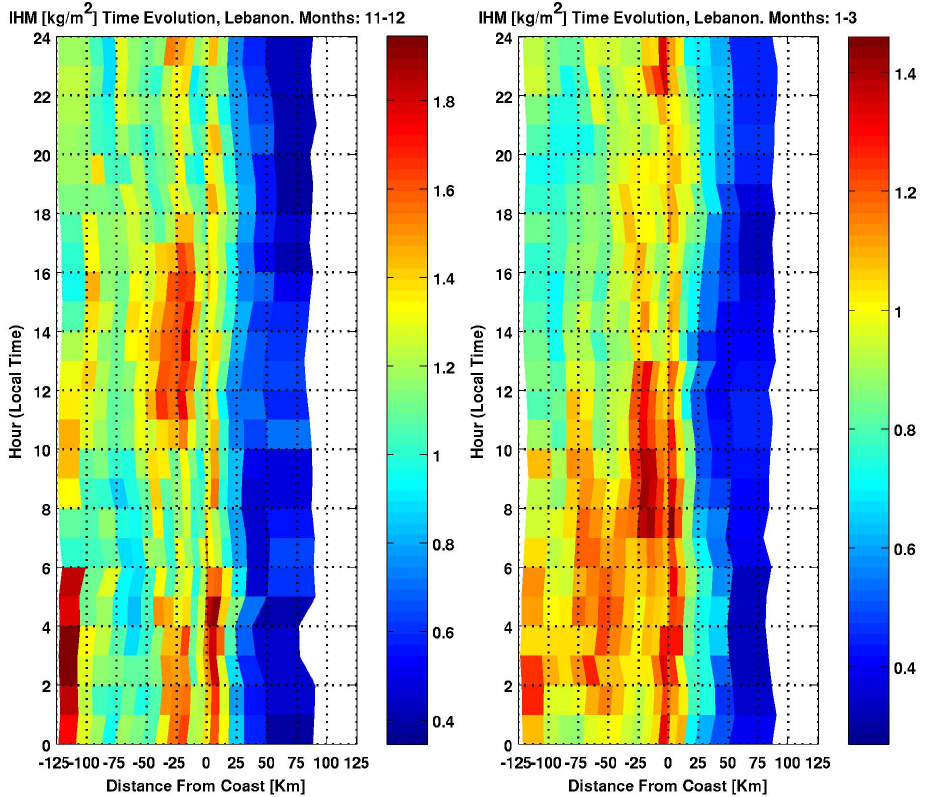
Fig. 10. Same as Fig. 8, but for “Lebanon” sub-region. The November–December, January–March mean counts per bin are 957, 1740,